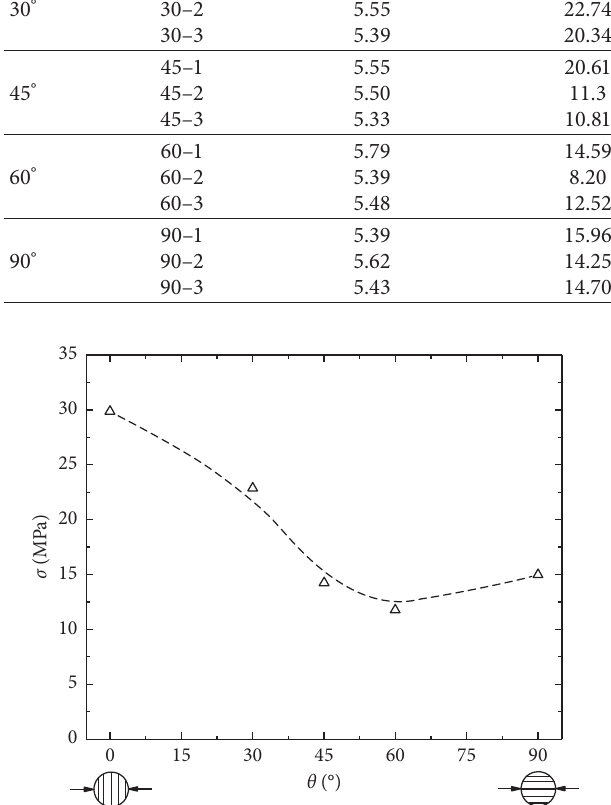
Figure 10: Dynamic “tensile strength” curve of the layered slate under different dip